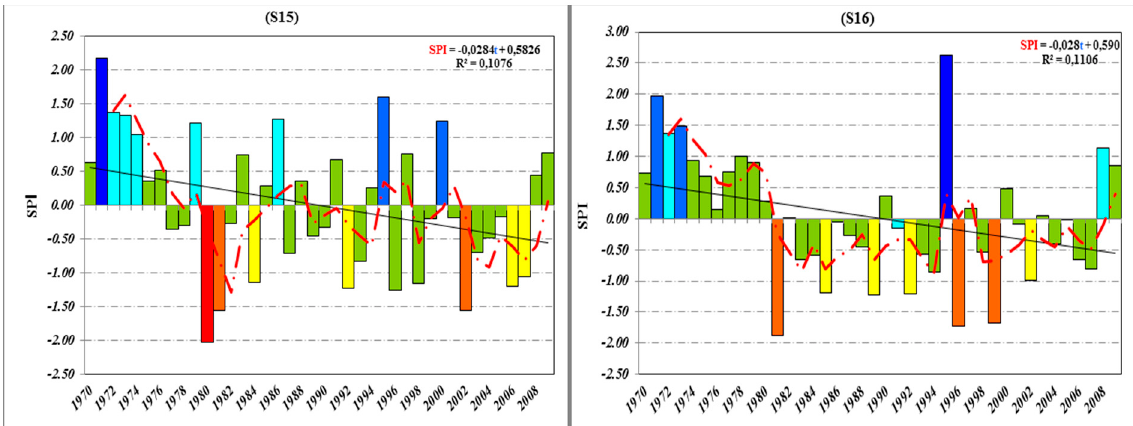
Figure 3. Annual SPI time series and its linear trend and 3 year moving average of the pluviometric stations of Wadi Mina basin. Note that colors are linked with drought classification based on Table 4. Number in branches above figures is number of station. Table 5. Values of statistics b, Z of the Mann–Kendall test for the annual SPI series (1970–2010).